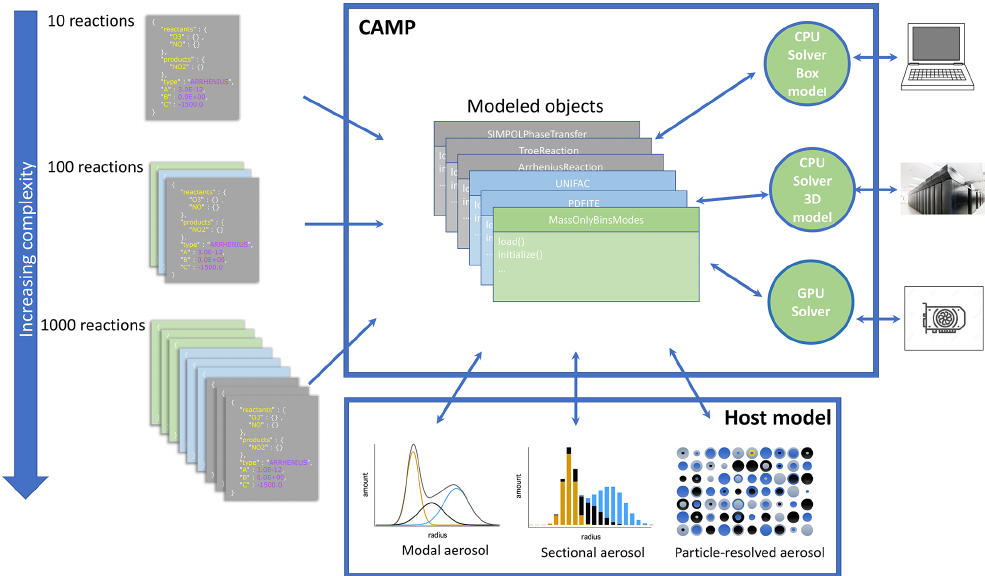
Figure 2. Schematic overview of the CAMP framework. The multiphase chemical mechanism is flexibly defined using standardized JSON files. This is converted into an internal representation of model objects. This interfaces with the aerosol representation (modal, sectional, particle-resolved) determined by the host model and can be coupled to solvers that are appropriate for the compute requirements of the application (CPU or GPU solvers on platforms ranging from personal computers to high-performance